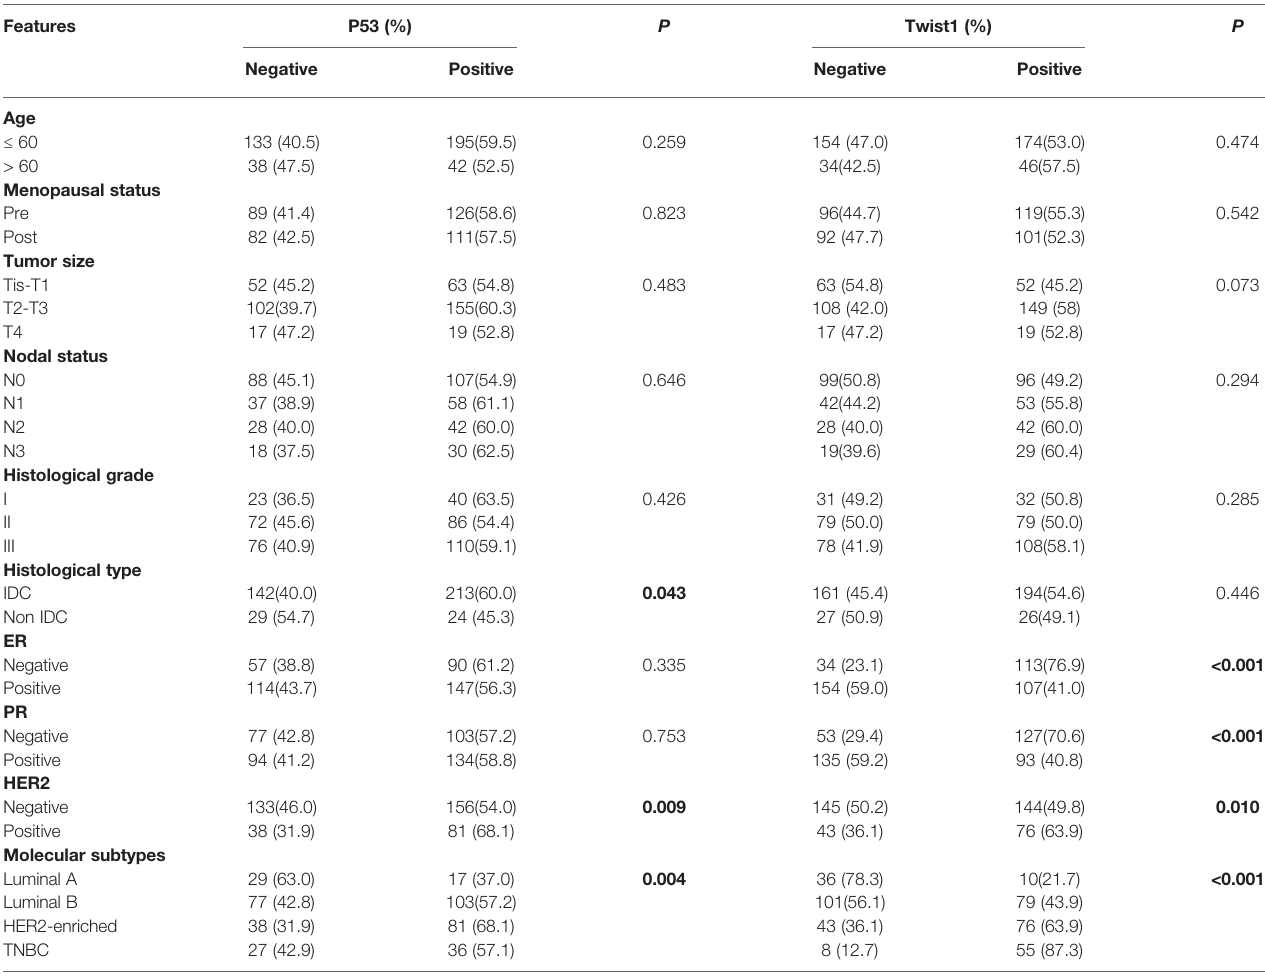
TABLE 1 | Association between mutant p53 and Twist1 expression and clinicopathological characteristics in breast cancer patients (n = 408). Features